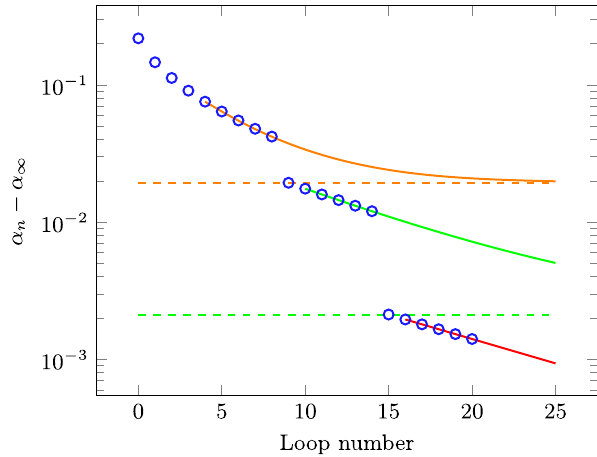
FIG. 6. Example of the exponential trend when iterating to self- consistency. The mean-field amplitude over loop number n is denoted by α and converged amplitude [as defined by Eq. (21)] n by α ∞ . The system parameters are L ¼ 60 , U ¼ − 10 t , t ⊥ ¼ 0 . 4 t , β